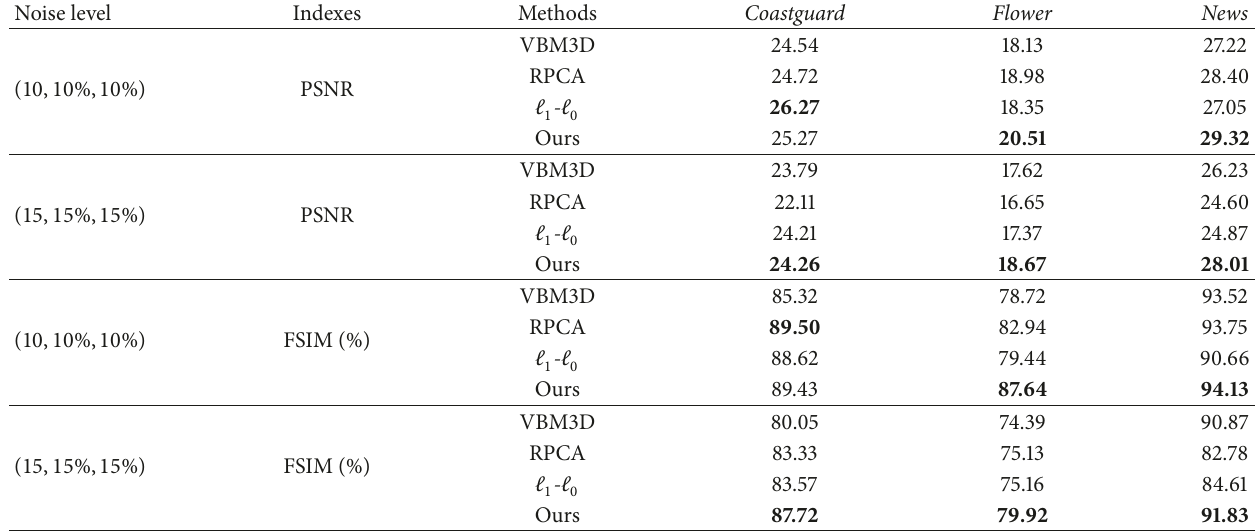
Table 2: Numerical results by the removal of GSPRV, measured by PSNR and